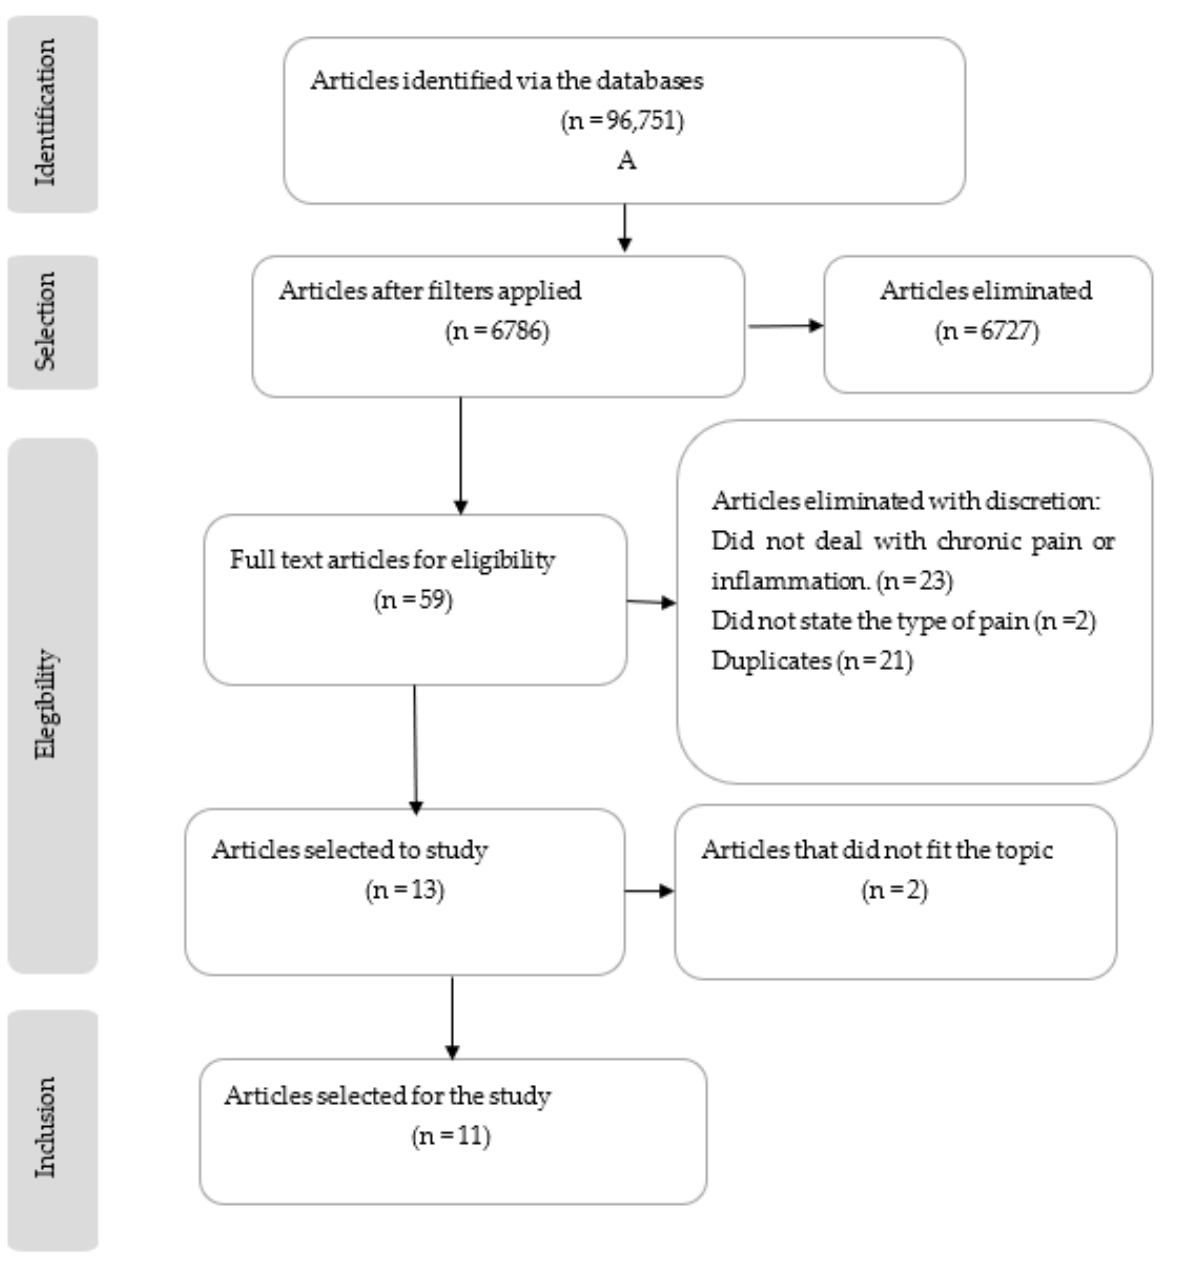
Figure 1. Flow diagram following PRISMA system. Selection and exclusion process for the studies.